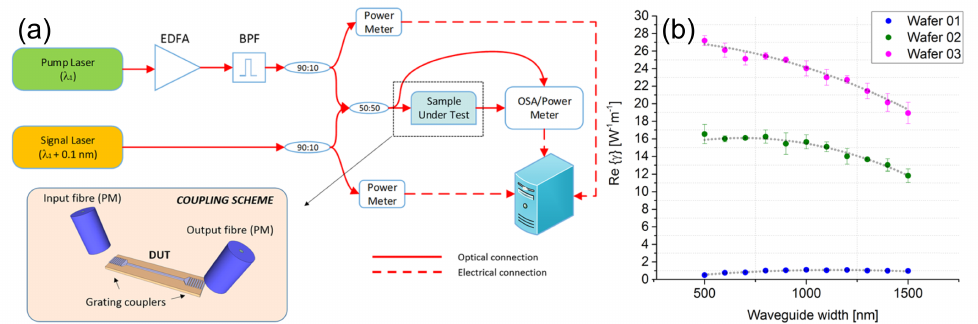
Figure 5. ( a ) CW-FWM experimental setup. BPF: bandpass filter; EDFA: Erbium-doped fibre amplifier; OSA: optical spectrum analyser. ( b ) Experimentally measured Re γ for each waveguide geometry, on each Si-rich SiN layer. Reproduced from [39] under a CC BY 4.0 license.